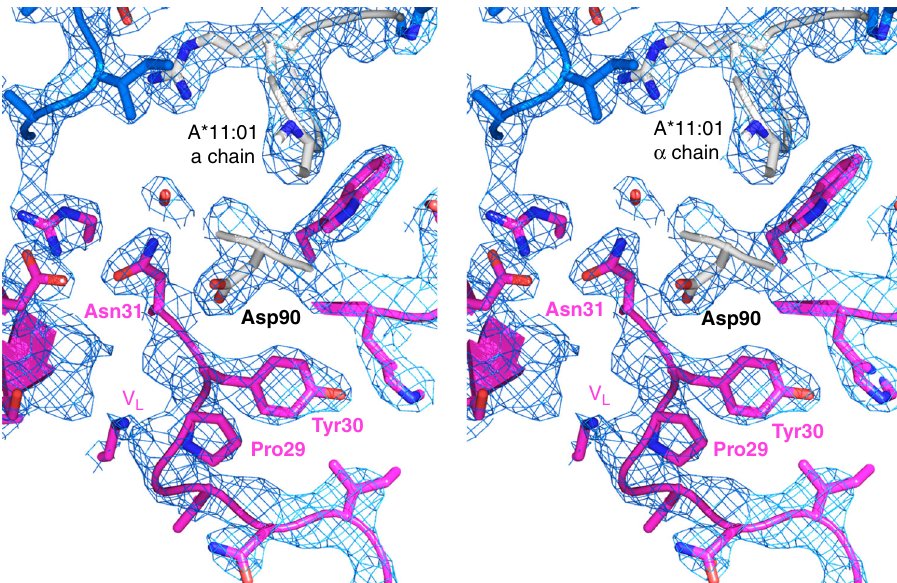
Fig. 6 A 2Fo-Fc map showing the interaction between 2E3-Fab light chain and Asp90 of HLA-A*11:01. The map contour level is 1.0 sigma (0.1826 e/Å 3